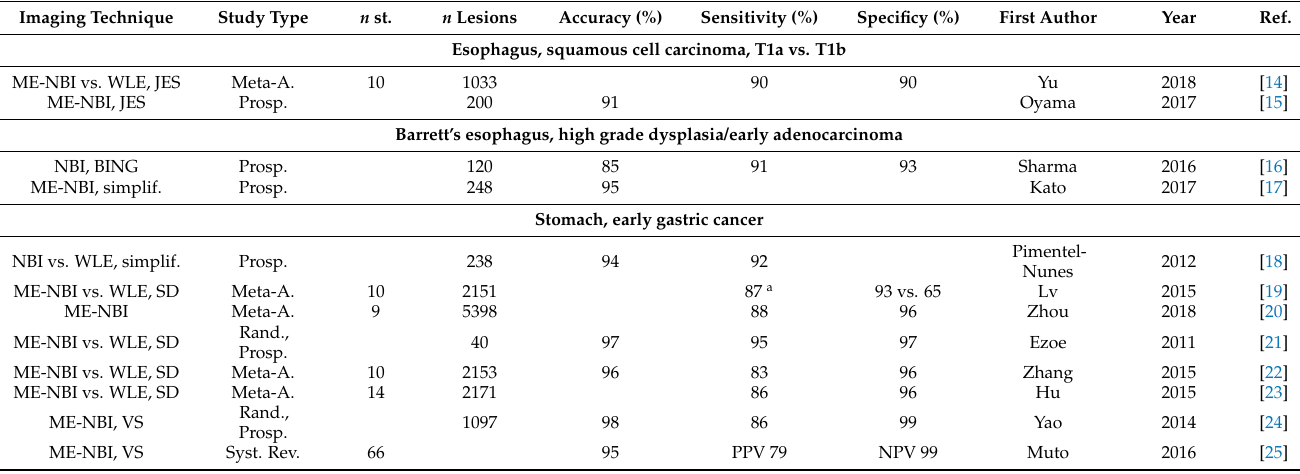
Table 1. Studies obtained by the systematic literature search on optical diagnosis of gastrointestinal neoplasia. Imaging